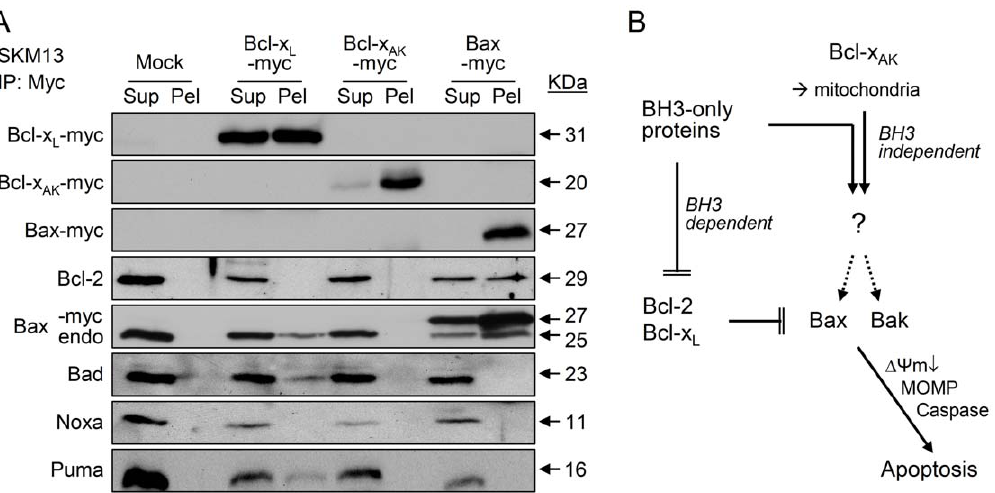
Figure 7. Co-immunoprecipitation analyses of Bcl-x AK with Bcl-2 family members. (A) SK-Mel-13 melanoma cells were transiently transfected with each 5 m g of pcDNA3 plasmids encoding Bcl-x L , Bcl-x AK , Bax or empty vector (Mock). Cells lysates were immunoprecipitated with microbeads covered with anti-Myc antibody, and immunoprecipitates were analysed by Western blotting. Non-bound supernatants (S) were compared with the immunoprecipitated pellet fractions (P). Antibodies for immunodetection: anti- Myc, Bcl-2, Bax and Bad. The complete experiment was performed two times, which both gave the same result. (B) A model for apoptosis induction by Bcl-x AK is suggested. It is based on mitochondrial translocation of Bcl-x AK and activation of Bax/Bak. Bcl-2/Bcl-x L prevent Bax/Bak activation but not Bcl-x AK translocation. BH3-only proteins may mediate a BH3 domain-dependent pathway via inactivation of antiapoptotic Bcl-2 proteins and may also drive a BH3-independent pathway analogous to Bcl-x AK (see discussion part).